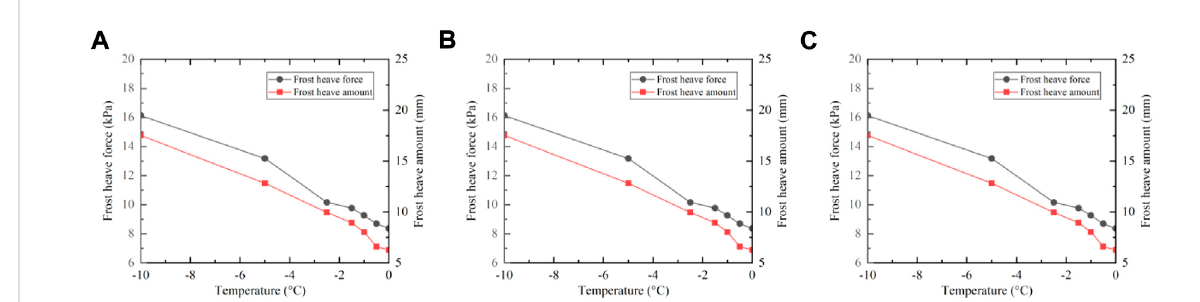
FIGURE 4 Change rules of frost heave force and amount in group B. (A) Section 1. (B) Section 2. (C) Section